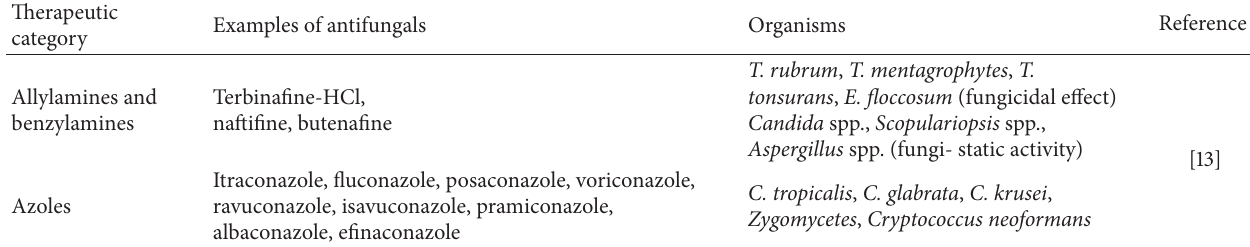
Table 2: Antifungal agents utilized in the treatment of